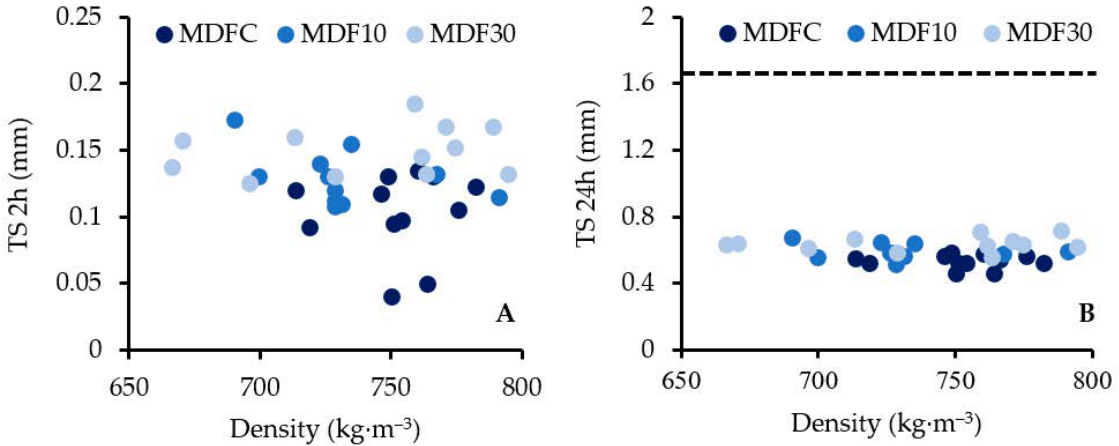
Figure 3. Thickness swell as function of density of MDF panels. ( A ) Thickness swell after 2 h as a function of density of MDF panels. ( B ) Thickness swell after 24 h as a function of density of MDF panels. The dotted line represents the maximum TS for panels < 15 mm according to ANSI A208.2-2016. The Pearson correlation among average density values and water absorption and thickness swelling is presented in Table 6. There is a significant correlation between the average density of MDF30 and water absorption after 24 h, which is a strong positive correlation. On the other hand, there is no significant correlation between the rest of the variables. Table 6. Pearson correlation for average density values and water absorption and thickness swelling of MDF panels.